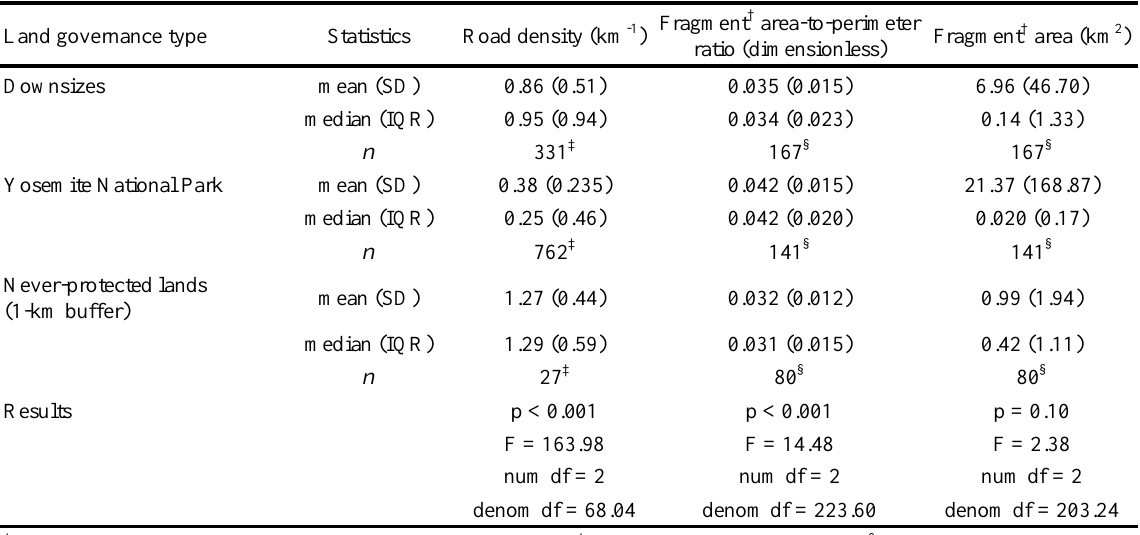
Table 2. Habitat fragmentation indicators at the Park scale for forested lands; results of Welch’s ANOVA tests. See Table